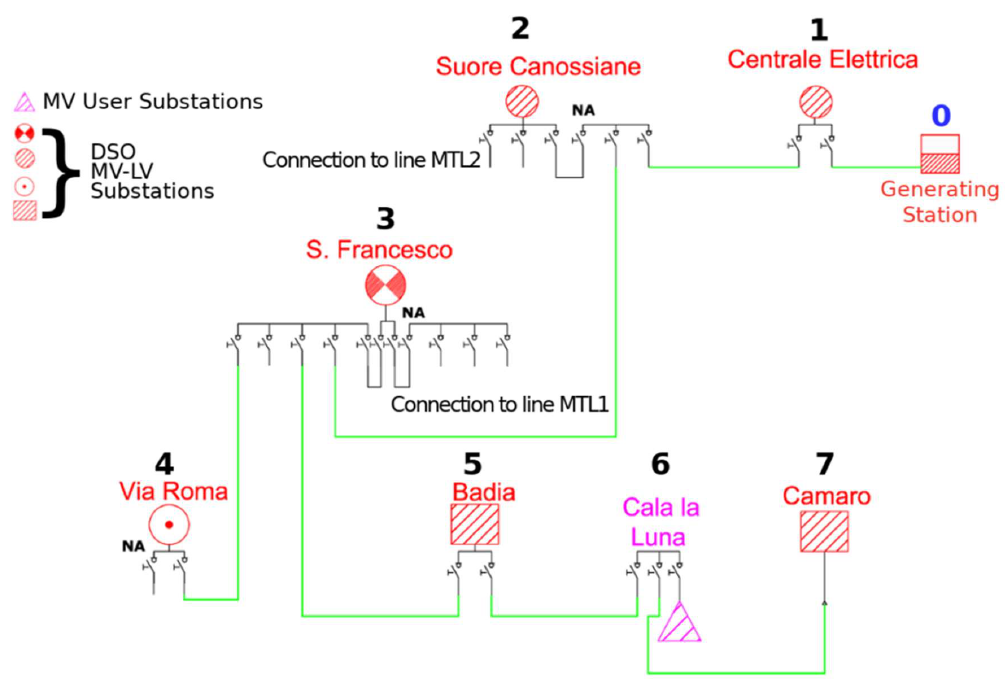
Figure 7. Electrical scheme of the feeder “MT L3” of the Favignana MV distribution network.